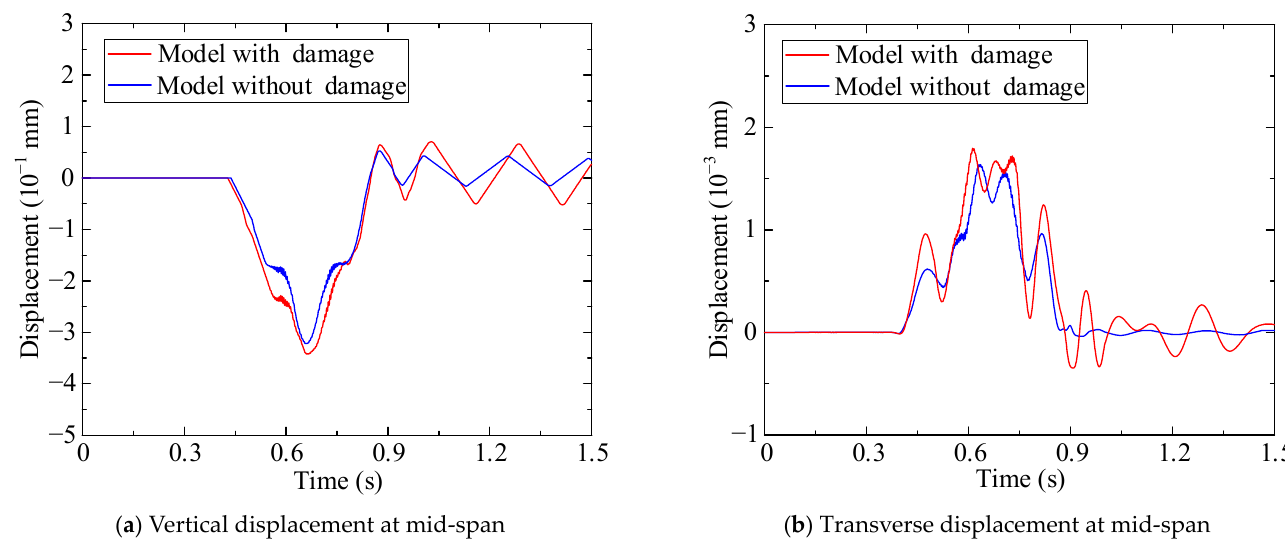
Figure 24. Responses of the composite beam at a train speed of 330 km/h in the case of T-1.